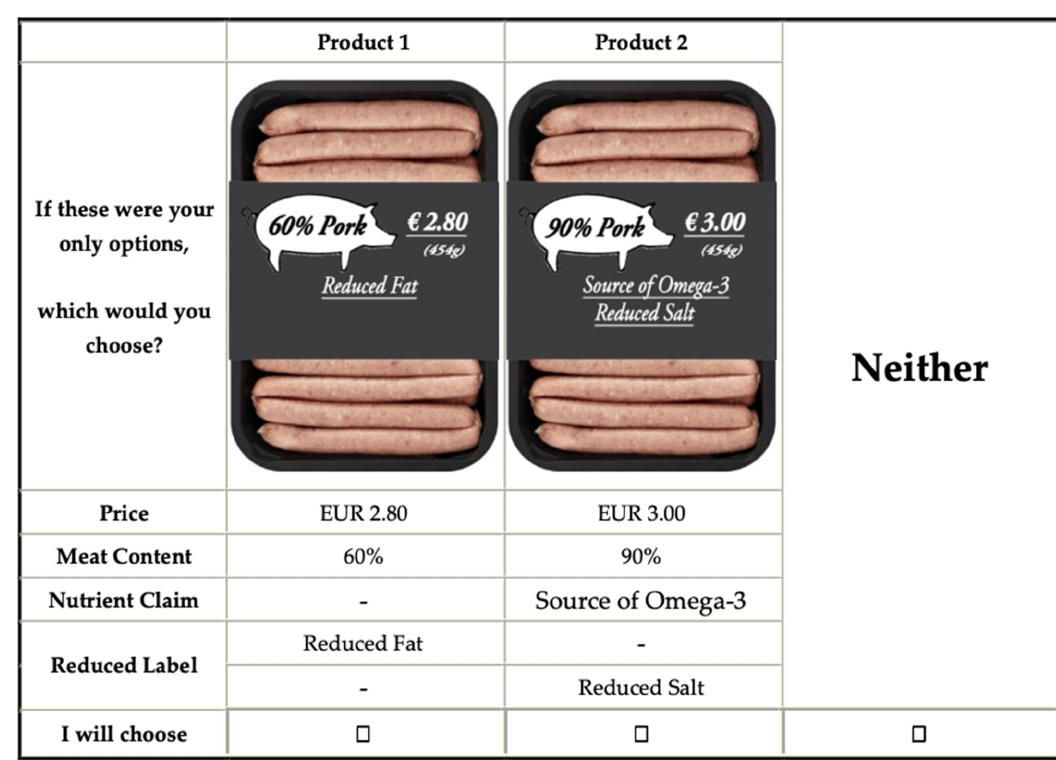
Figure A9. Choice set 9 in the questionnaire